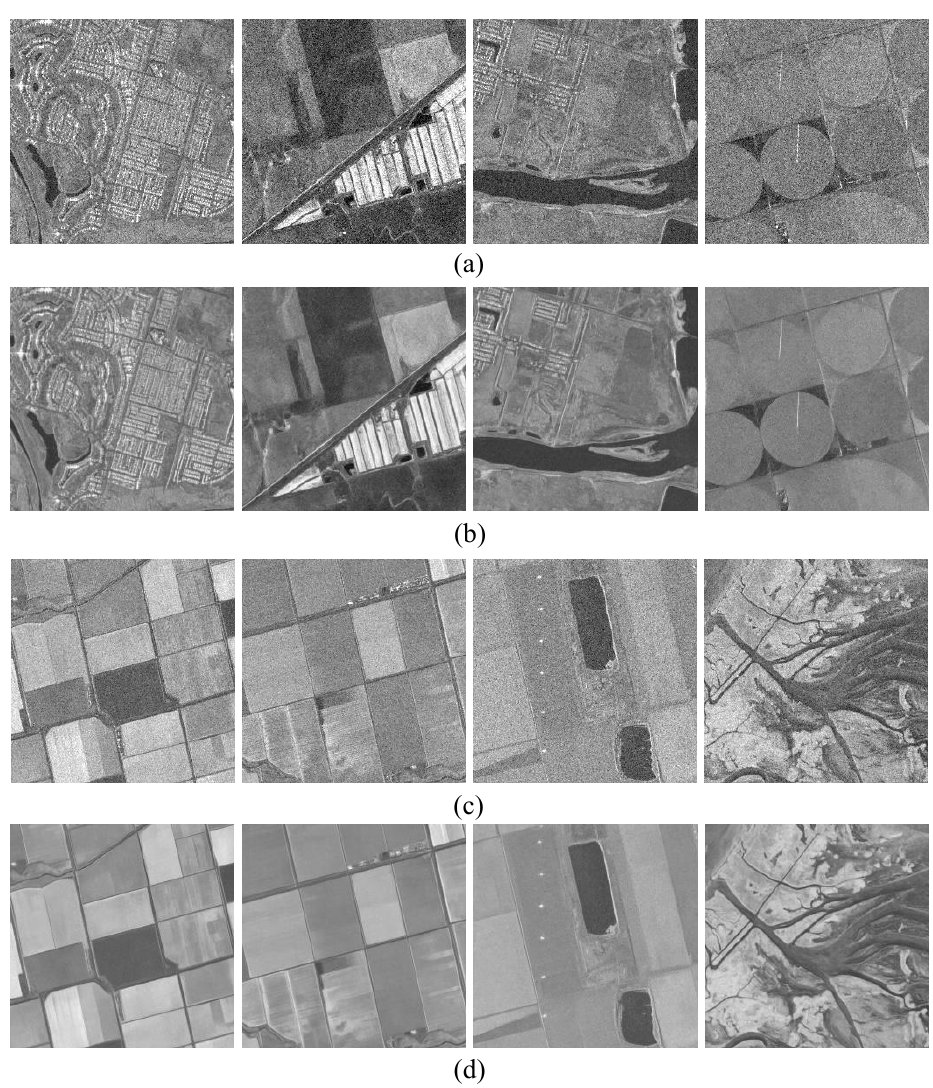
Figure 13. The despeckled results of the SSEUNet in real-world SAR images. ( a , c ) Real-world SAR images. ( b , d ) Despeckled